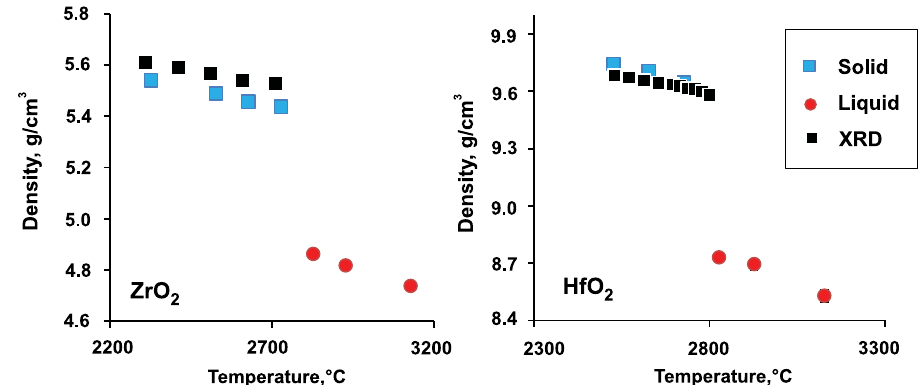
Figure 3. Density change on melting of cubic ZrO 2 and HfO 2 from ab initio MD computations with overlayed experimental results from high temperature X-ray diffraction (XRD). Uncertainties from computation and experiment are smaller than the symbol size. (The computational results are in Table 1, the results of Pawley refinement of XRD patterns are provided in Supplementary